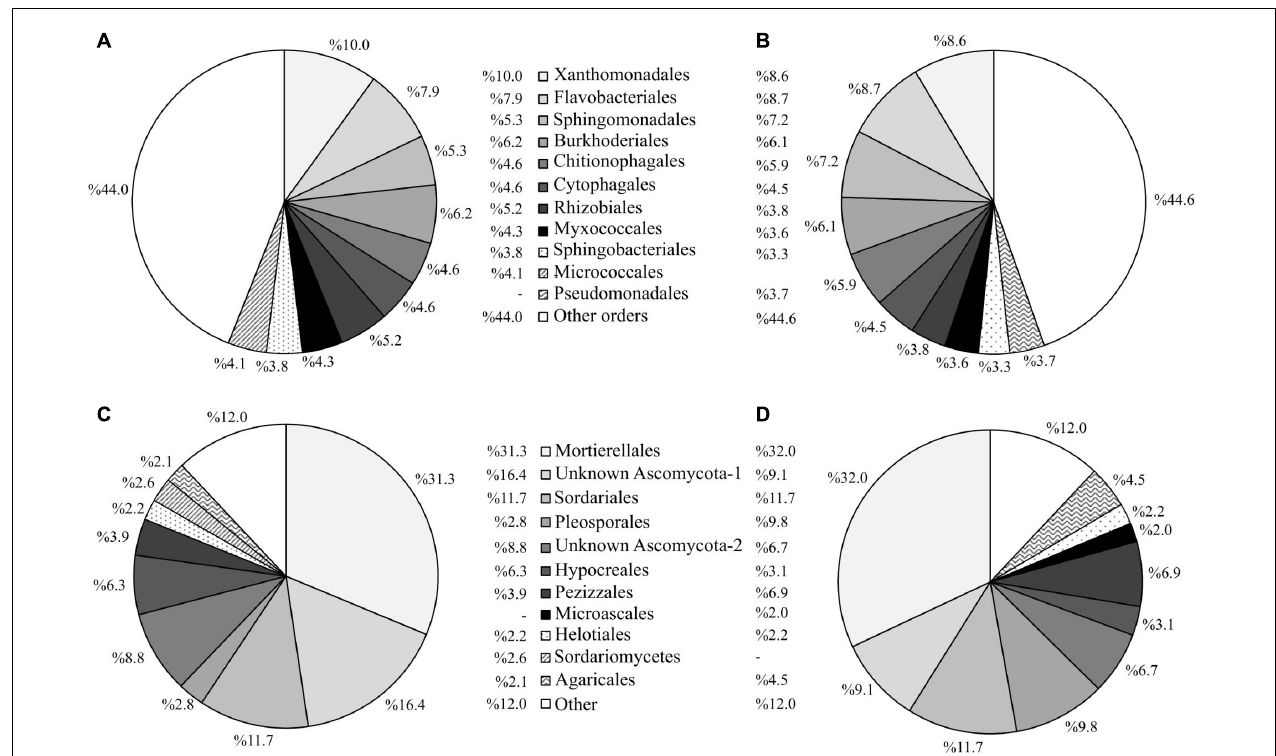
FIGURE 8 | Abundance profiles of the 10 most abundant prokaryotic and fungal taxa at order level for plots under the experimental factor “mycorrhizal inoculation” at the end of the experiment. Abundance of prokaryotic taxa in plots with mycorrhizal (A) and non-mycorrhizal (B) poplars. Abundance of fungal taxa in plots with mycorrhizal (C) and non-mycorrhizal (D)